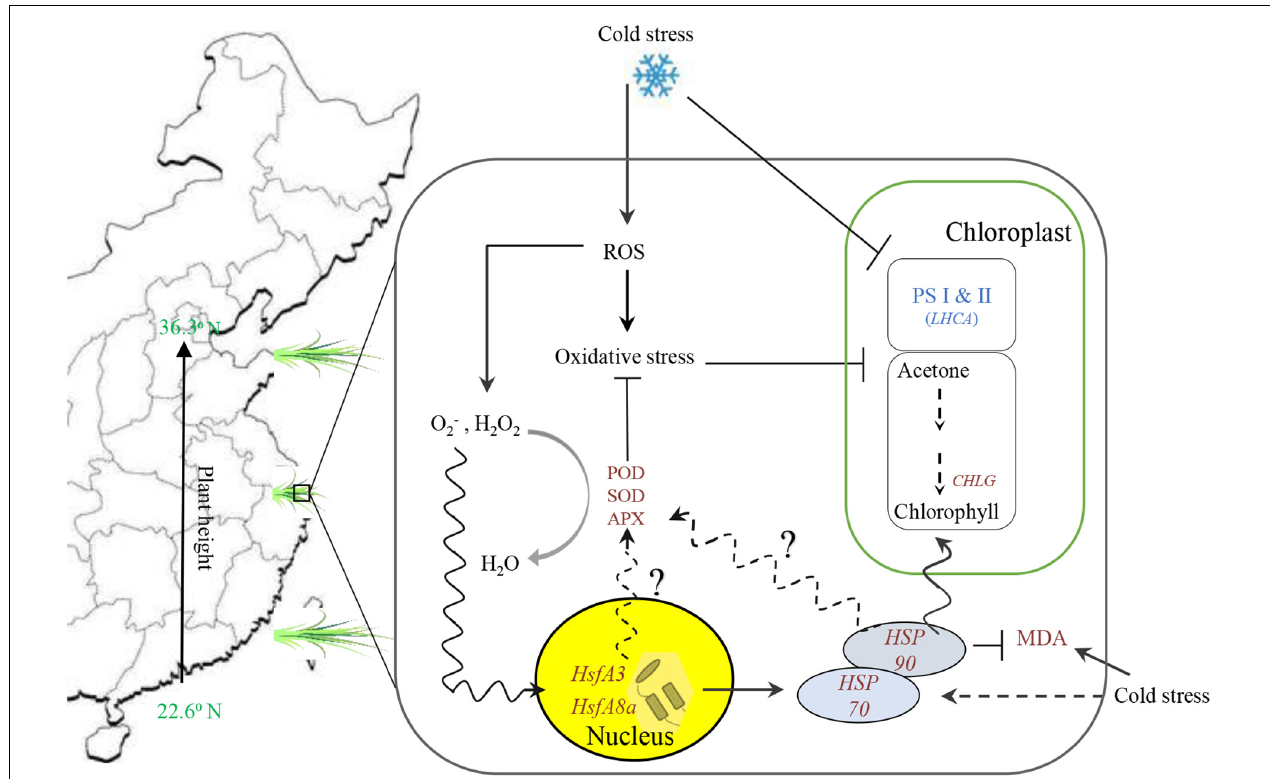
FIGURE 9 | Summary of the overall results count for putative mechanism among heat shock modules (Hsp and hsfs included), photosystem and chlorophyll biosynthesis, and redox system in bermudagrass under cold